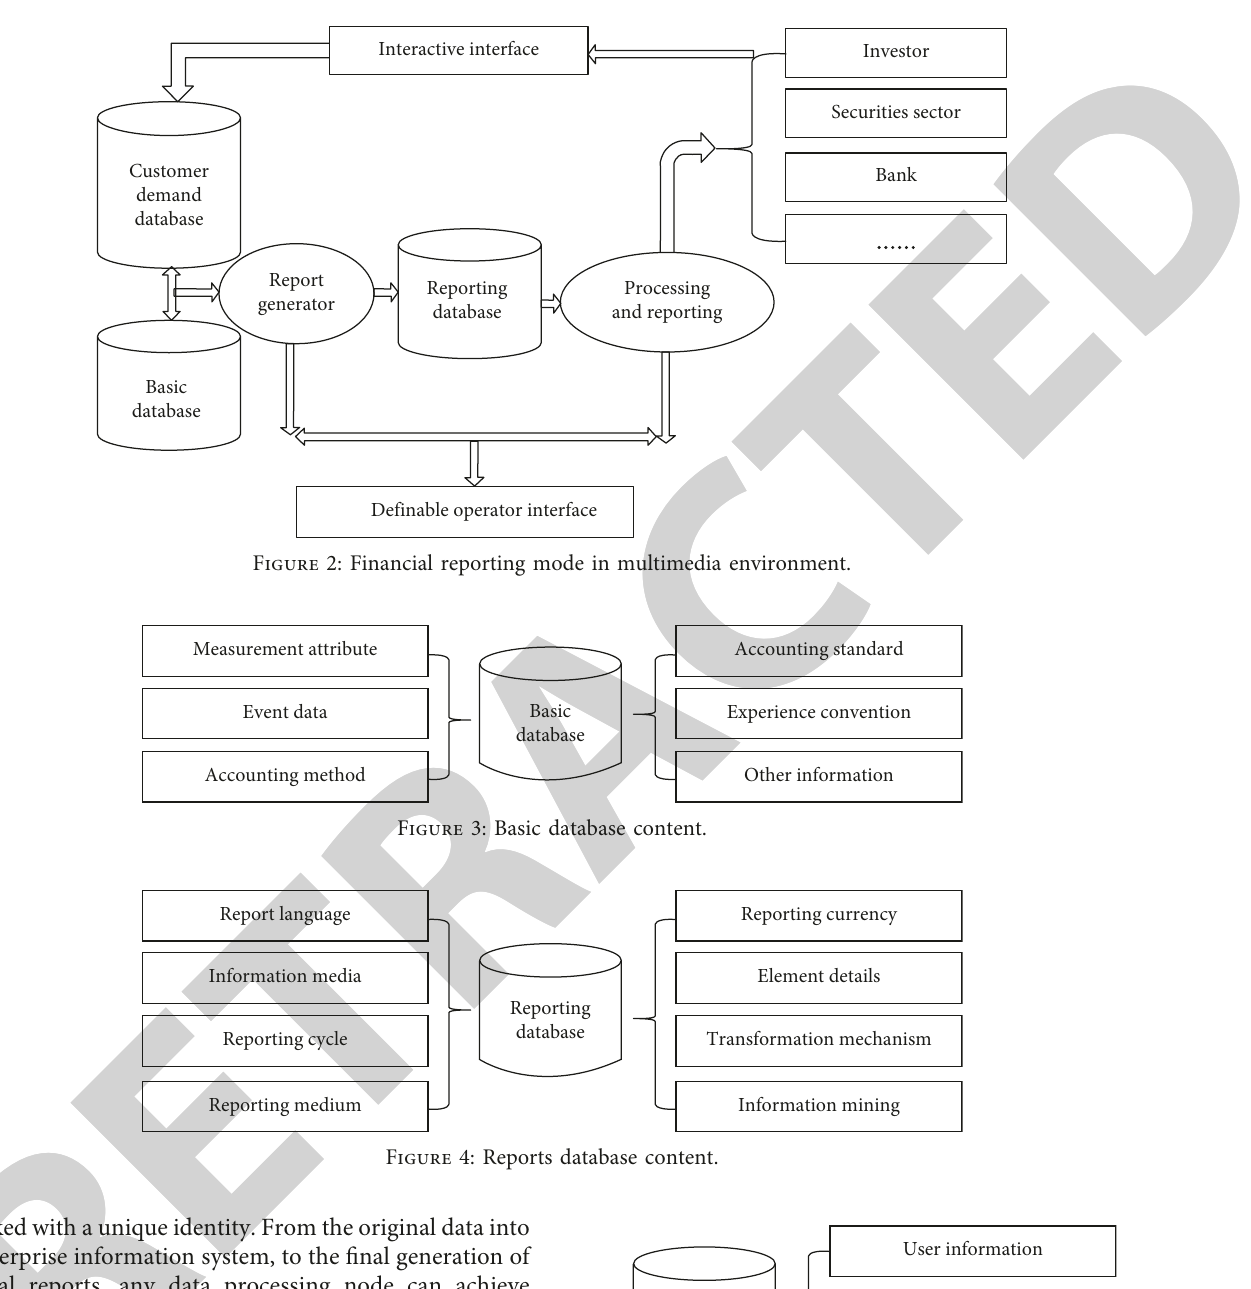
Figure 4: Reports database content.